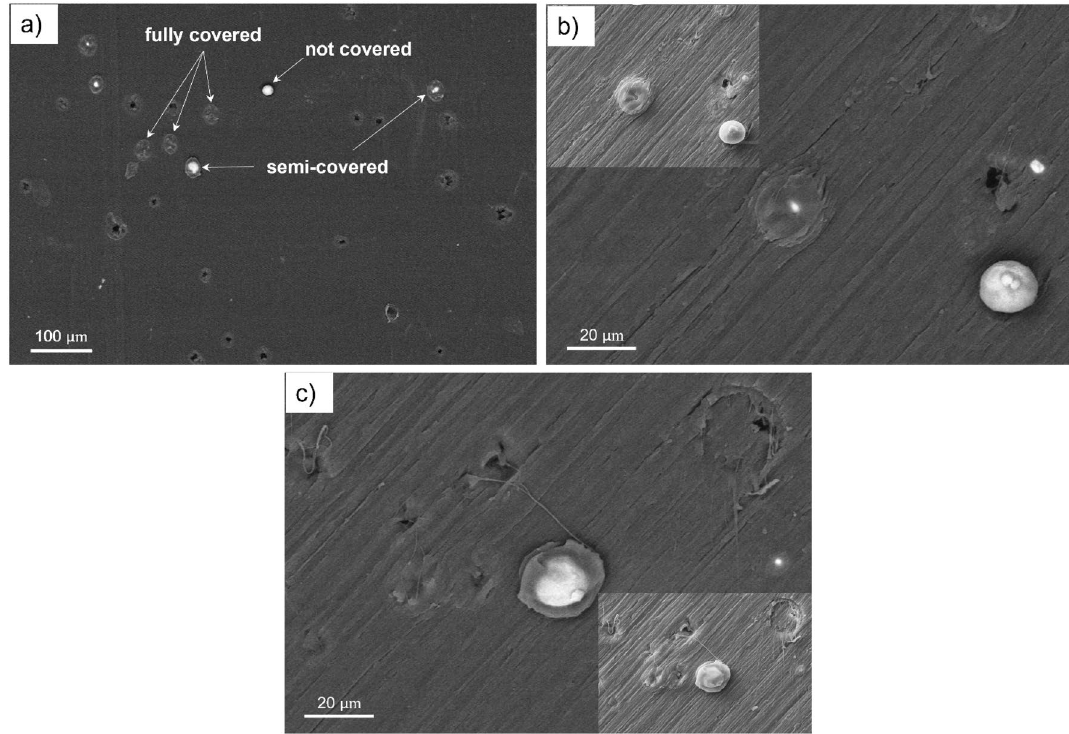
Figure 4. SEM illustration (BSE micrographs) of the PEEK substrate surface after a single-particle impact experiment with V p = 498 m / s and T p = 101 ◦ C : ( a ) at low magnification ( b ) at high magnification depicting fully cov e red and not covered and ( c ) semi-covered particles (the inserts are SE micrographs).